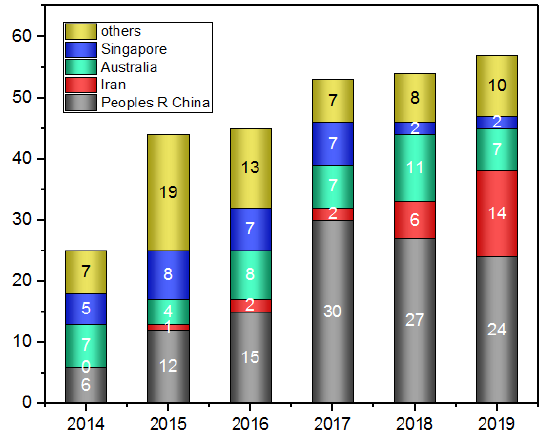
Figure 2. Number of research papers on the novel FO membrane in recent Figure 2. N umber of research papers on the novel FO membrane in recent years.